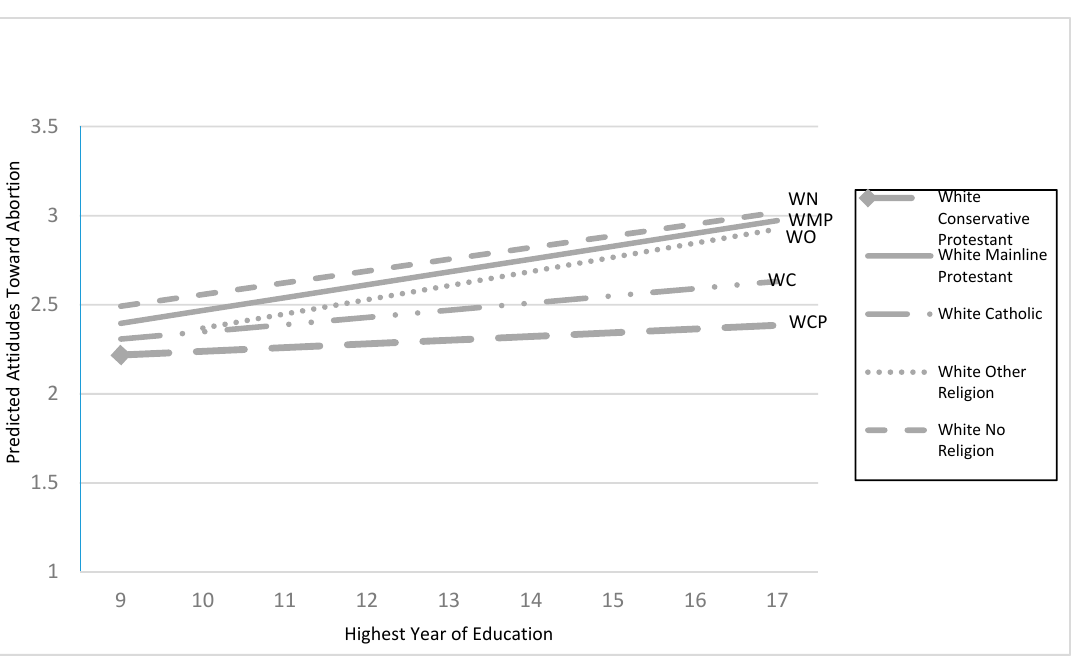
Figure 1. The interaction of religion and education on views on abortion.